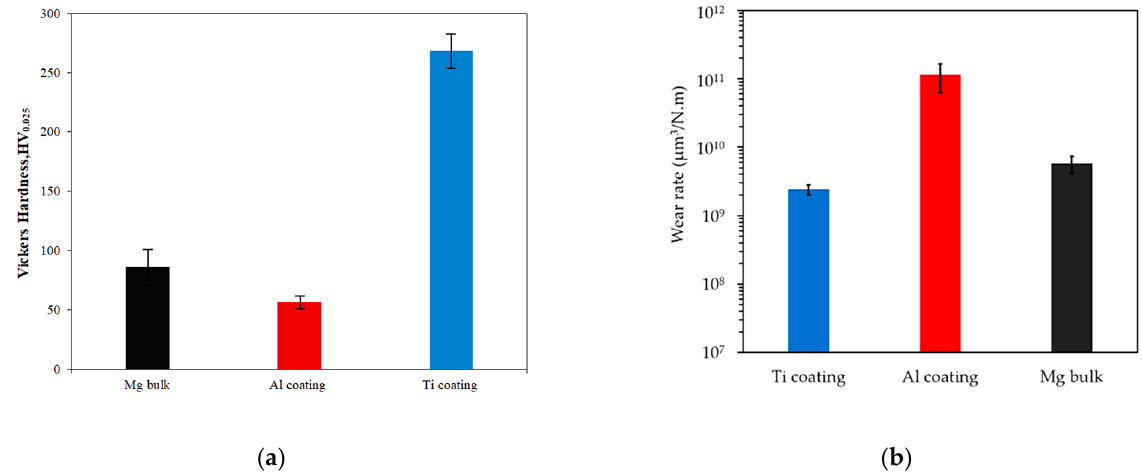
Figure 4. XRD patterns of ( a ) bare AZ31B, ( b ) as-received Al powder particles and as-sprayed Al coating, and ( c ) as-received Ti powder particles and as-sprayed Ti coating.